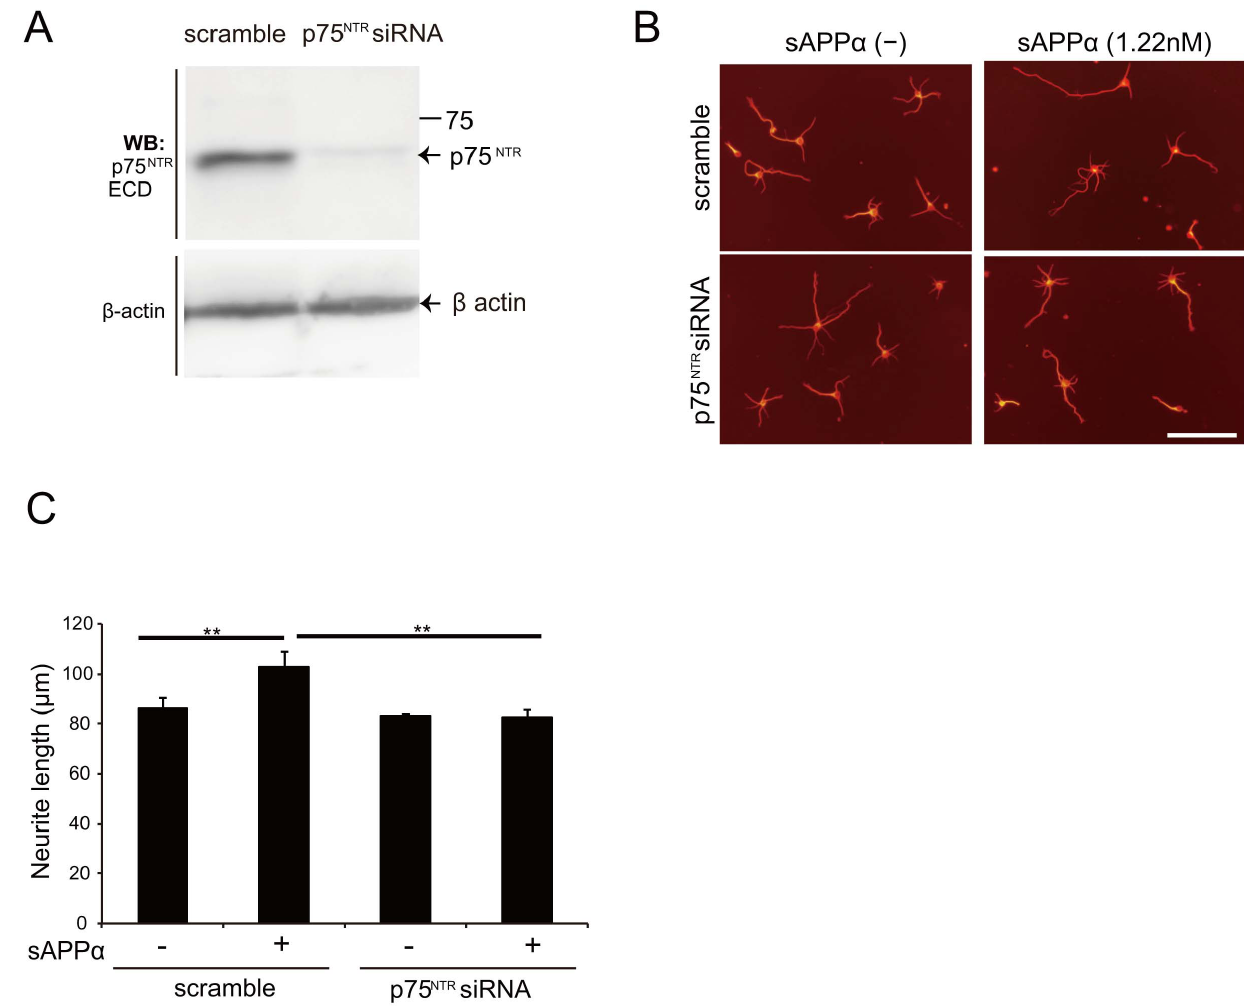
Figure 4. p75 NTR mediates sAPP a -induced neurite outgrowth. (A) p75 NTR siRNA specifically reduced target protein expression. Cortical neurons were transfected with scrambled control or p75 NTR siRNA. Cell lysates were prepared 72 h after transfection and subjected to western blotting. b -actin expression was used as an internal control. (B, C) siRNA-mediated knockdown of endogenous p75 NTR suppressed sAPP a -induced neurite outgrowth. (B) Representative images of cortical neurons are displayed. Cortical neurons were transfected with scramble siRNA (control) or p75 NTR siRNA. Three days after transfection, the neurons were incubated in the presence or absence of sAPP a for 24 h. Scale bar: 100 m m. (C) The mean lengths of the longest neurite per neuron were measured by image J software and represented in the graph. The graph showed the mean 6 SEM from of three independent experiments. The number of neurons was 150 for each experiment. ** p , 0.01, Scheffe’s F test. doi:10.1371/journal.pone.0082321.g004 (Figure 1A). These results indicate that APP fragments interact with p75 NTR .